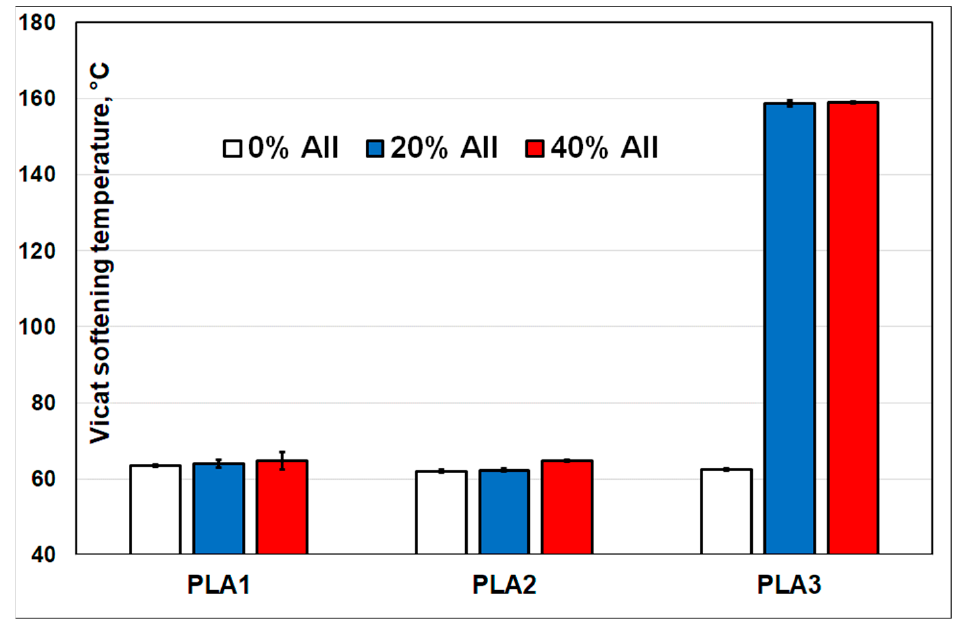
Figure 13. Vicat softening temperature (VST) of PLAs with different amounts of filler.